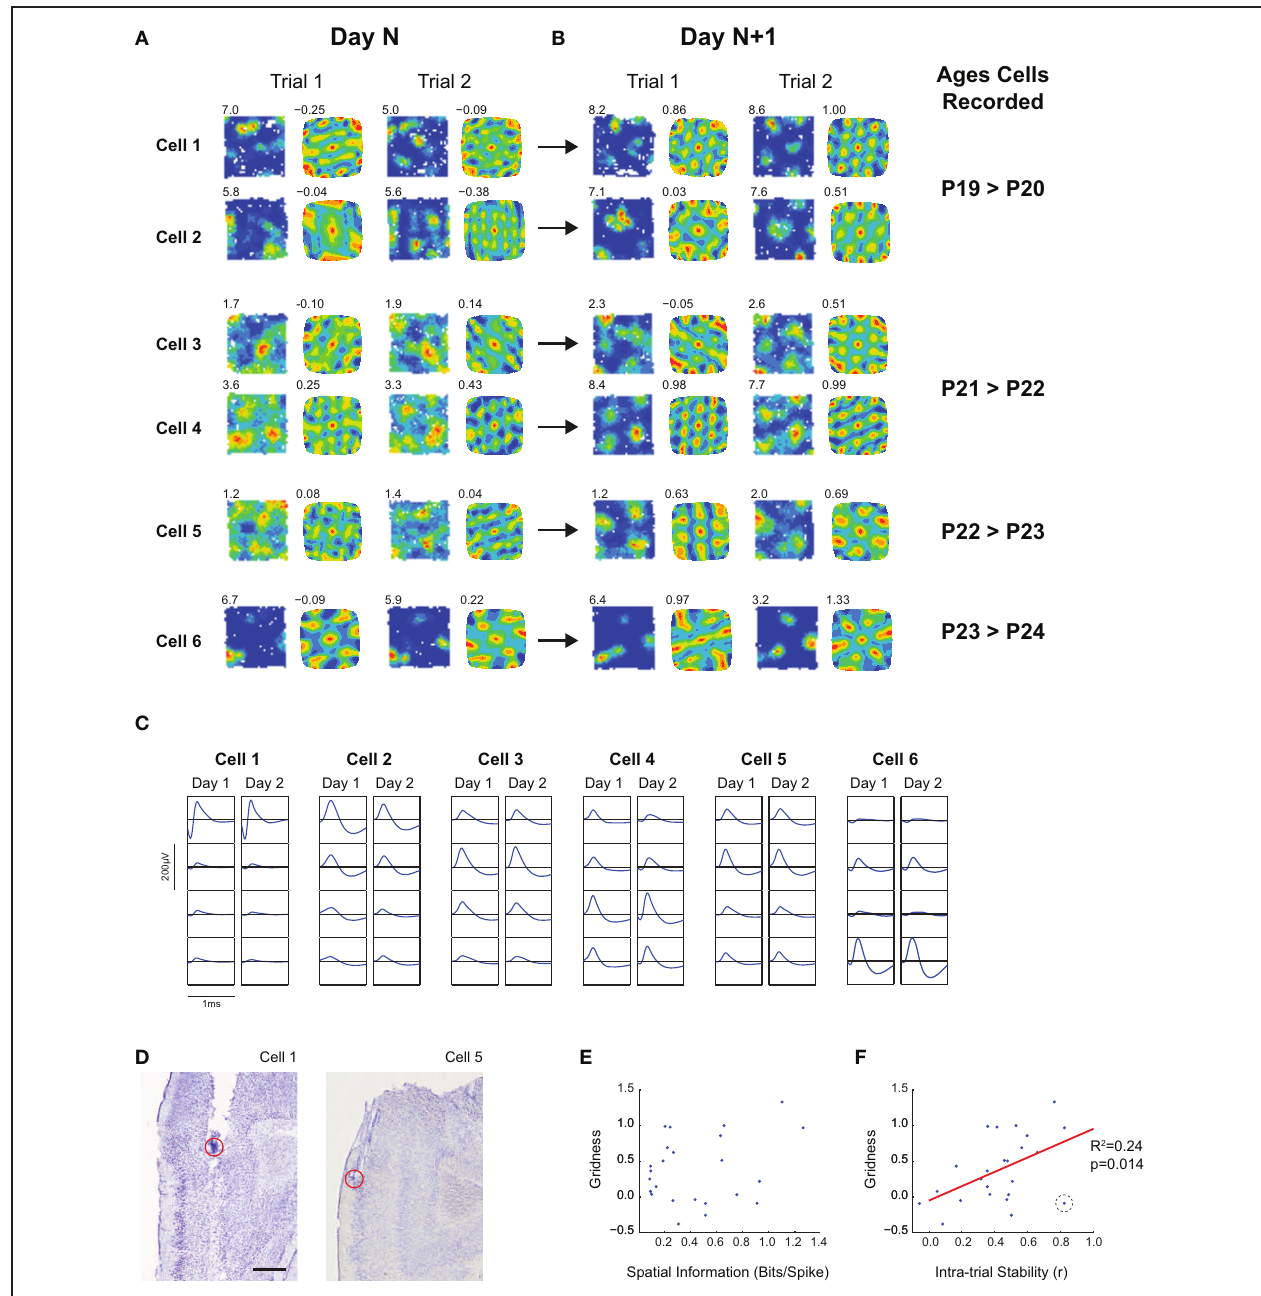
FIGURE 5 | The development of grid firing in individual mEC cells. (A,B) Firing rate maps and autocorrelograms for six mEC cells which were tracked for more than 1 day, and which developed stable grid cell firing patterns on the second day of recording. Text top left of firing rate maps shows peak firing, top-left of autocorrelogram shows gridness score for the trial. (A) shows two consecutive trials on the first day for which the cell was recorded (“Day N”), (B) shows two consecutive trials for the second day of recording (“Day N + 1”). The ages, in postnatal days, corresponding to Day N and Day N + 1 are shown to the right of (B) . (C) Extracellular waveforms for the six mEC cells shown in (A,B) . Each column shows the waveforms on the four wires of the tetrode on which the cell was recorded. For each cell, the left column shows the waveform for the last recording trial of Day N, the right column shows the recording trial of Day N + 1 with the highest gridness